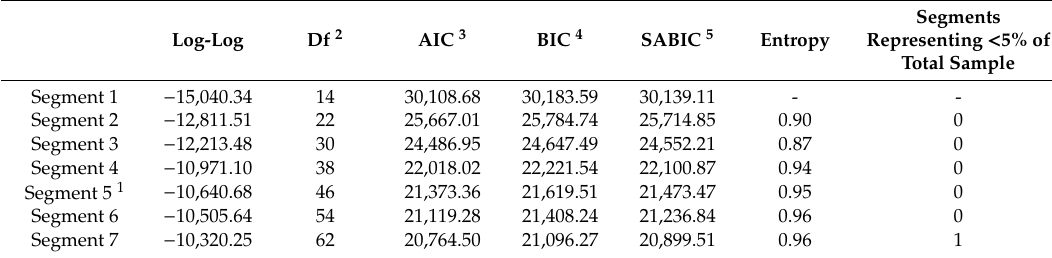
Table 2. Fit statistics for the one- through seven-segment models for the latent profile